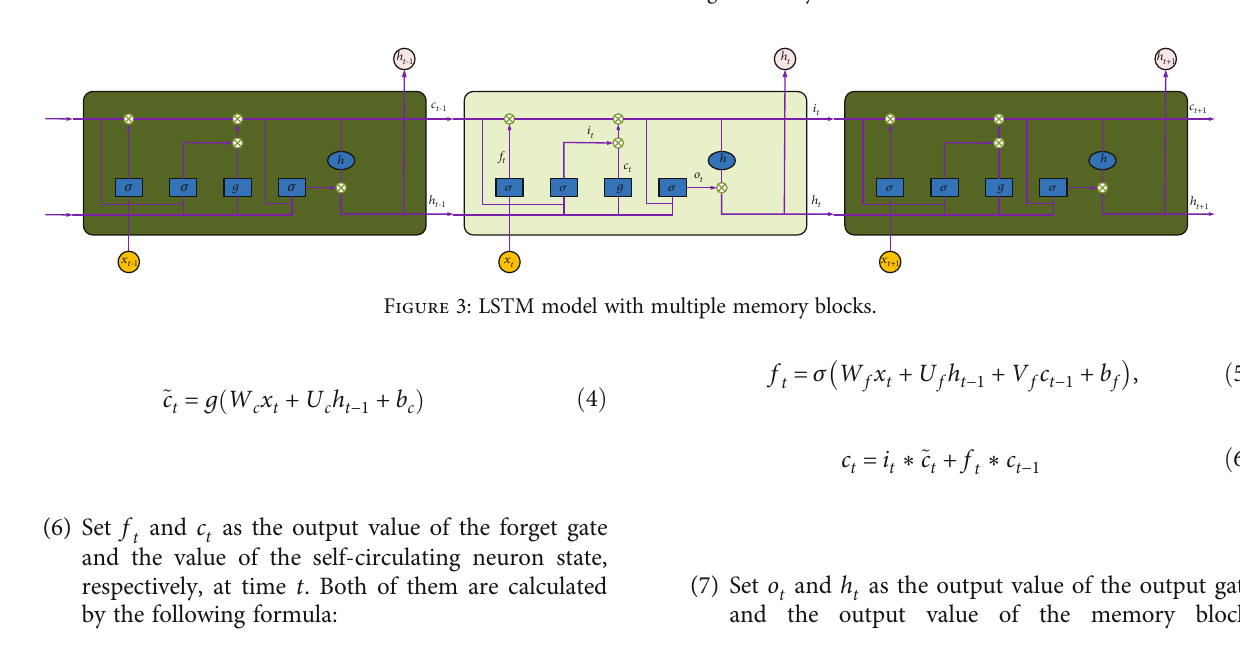
Figure 2: LSTM architecture of single memory block.